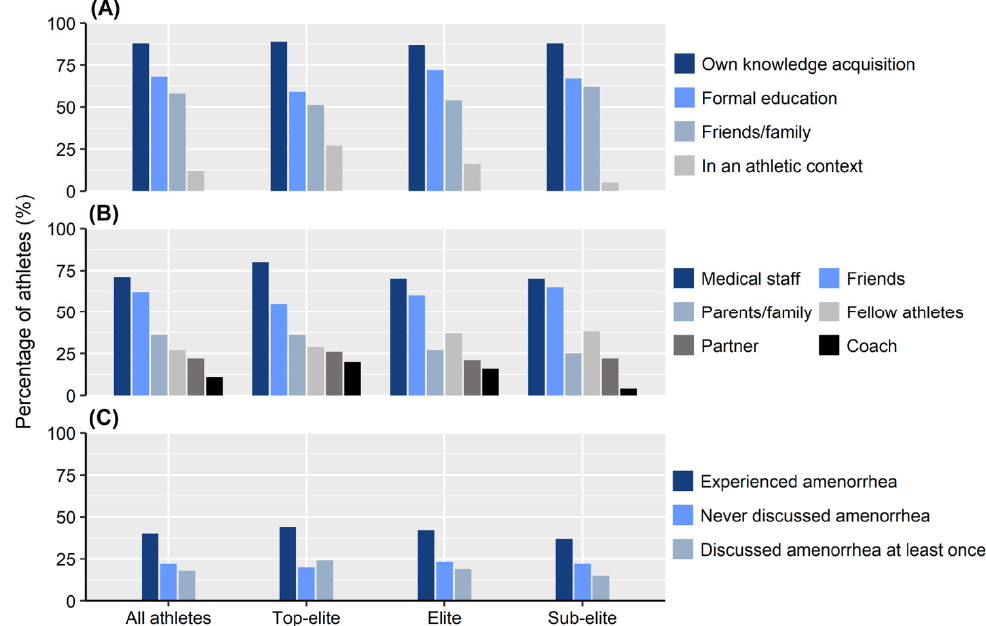
Figure 1. How knowledge about female athlete health was acquired ( A ), person to talk with about female athlete health ( B ) and opportunities to discuss amenorrhea, lasting > 3 months, in the athletic community ( C ).